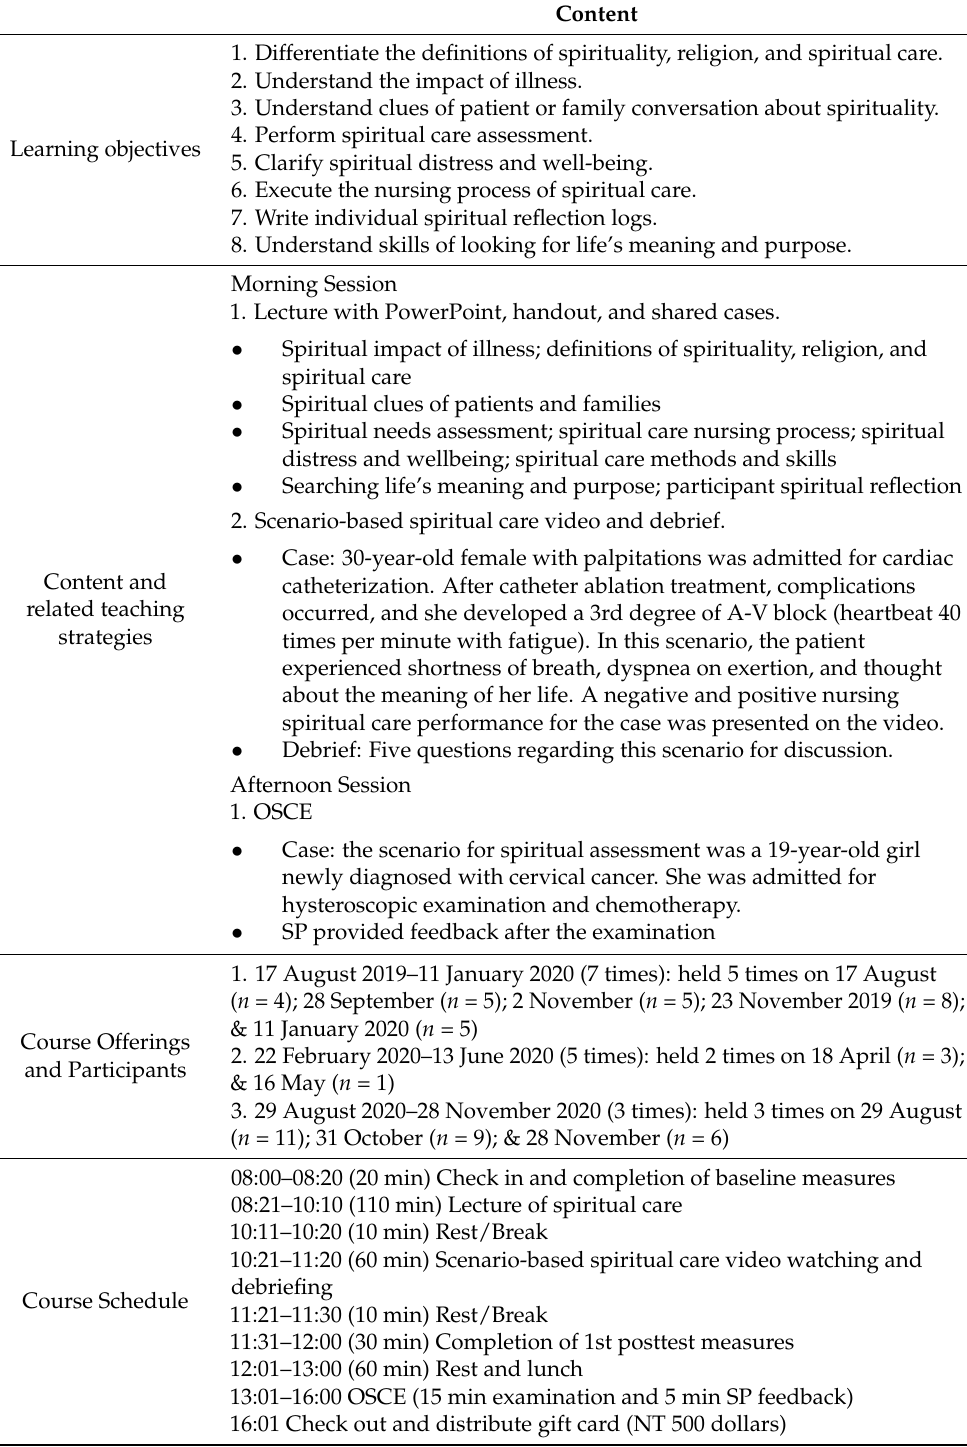
Table 2. The Spiritual Care Course Objectives, Teaching Content and Strategies, and